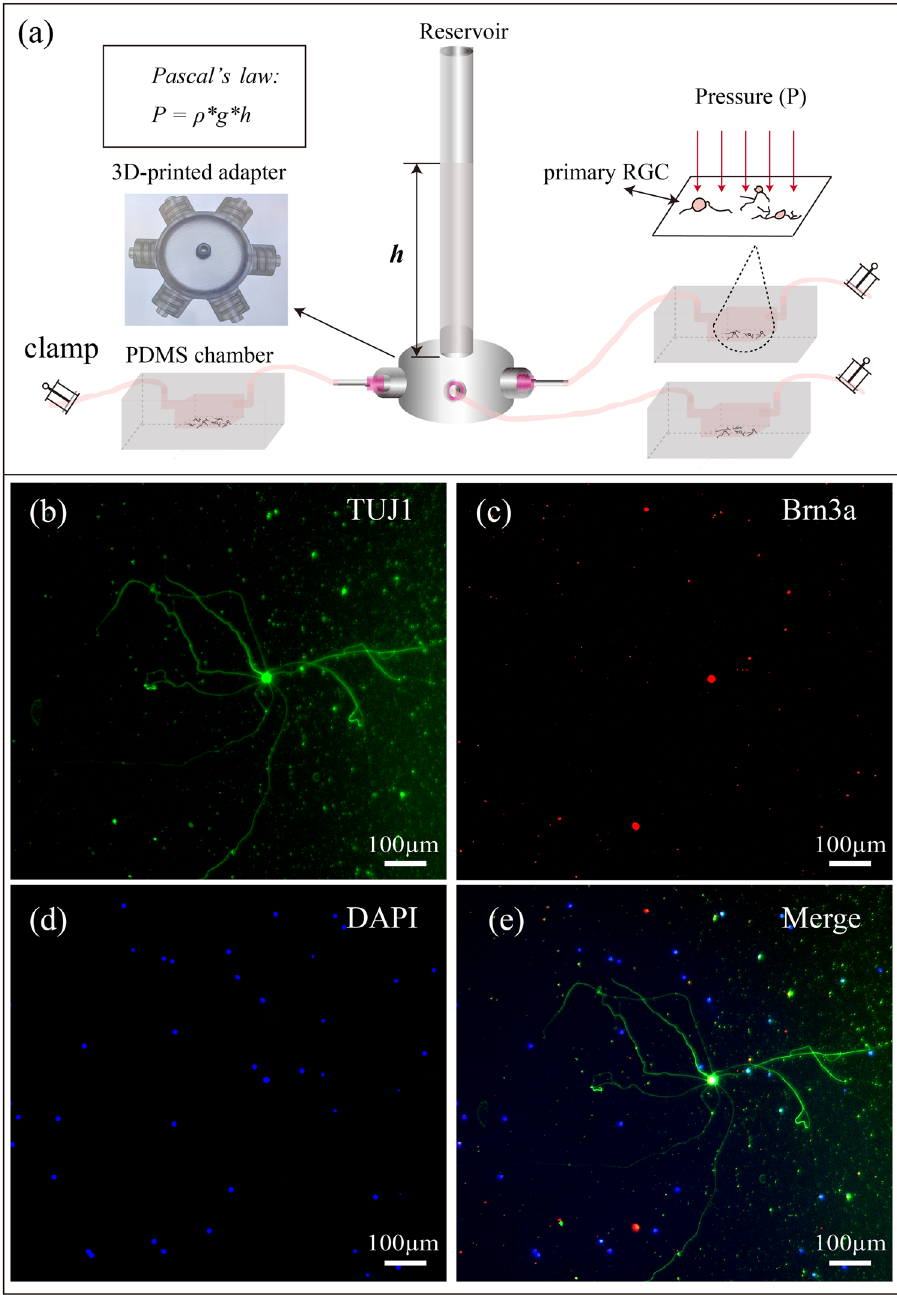
Figure 1. ( a ) A schematic diagram of the devised pressure apparatus for the application of adjustable hydrostatic pressure to primary RGCs using Pascal’s law. Multiple PDMS chambers, containing primary RGC cultures, are connected to a 3D-printed adapter via silicone tubing, and subjected to various hydrostatic pressures depending on the height h of FC-40 within the attached transparent reservoir. ( b – e ) Representative fluorescence images of primary RGCs cultured inside a PDMS chamber at day 3 in vitro . RGCs were positively stained with TUJ1 (green), BRN3A (Red) and DAPI (blue), which are neuronal-specific, RGC-specific and nucleus markers,